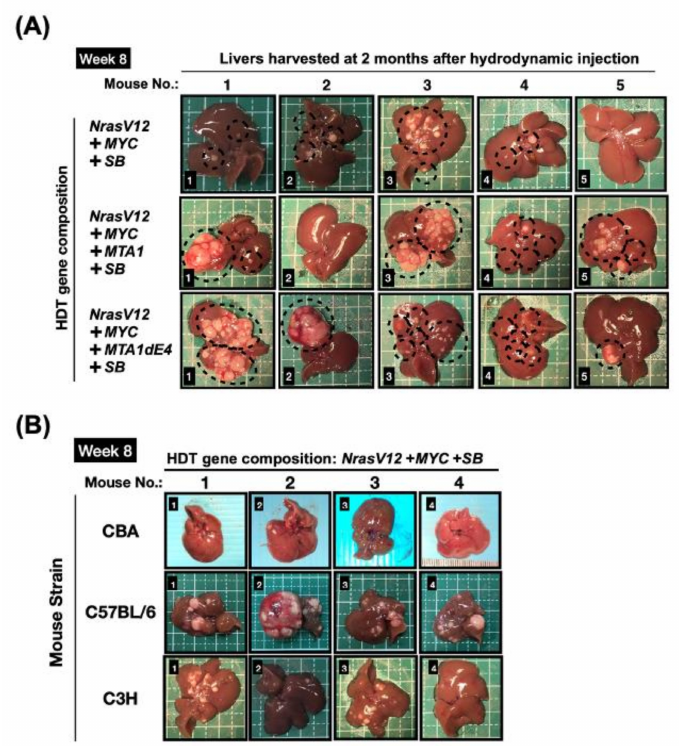
Figure 6. Application of the HDT-SB transposon methodology to investigate the collaboration effects of oncogenes and MTA1 as well as MTA1dE4 in terms of liver tumor induction. ( A ) Selected transposons were hydrodynamically delivered to the liver of C57BL/6JNarl mice together with plasmids encoding SB transposase. Gross morphology of representative livers harvested at 8 weeks post-HDT ( n = 5 per group). The position of the tumor is indicated by a white dashed circle. ( B ) The gross morphology of representative livers expressing the NrasG12V and MYC transposons as well as the SB transposase in the context of different mouse strains ( n = 4 per mouse